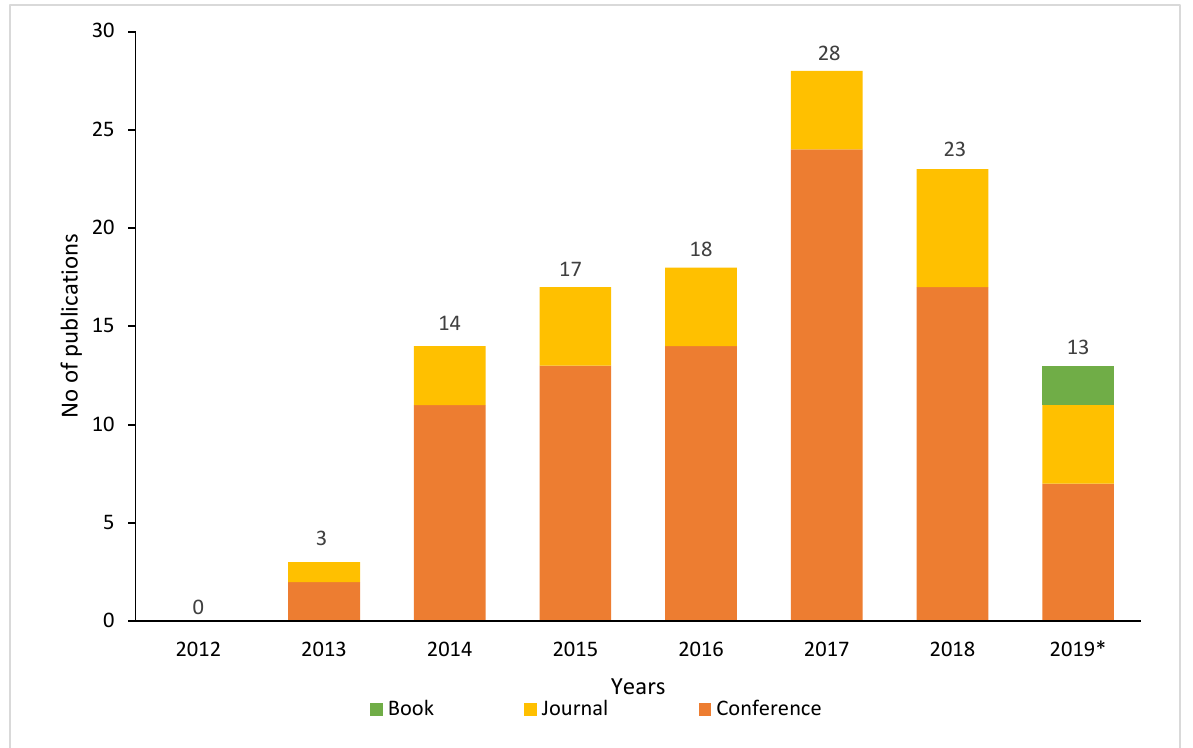
Figure 1. Yearly distribution of literature by type: journal article, conference paper, or book chapter. *2019 data includes research published only up to July 12,